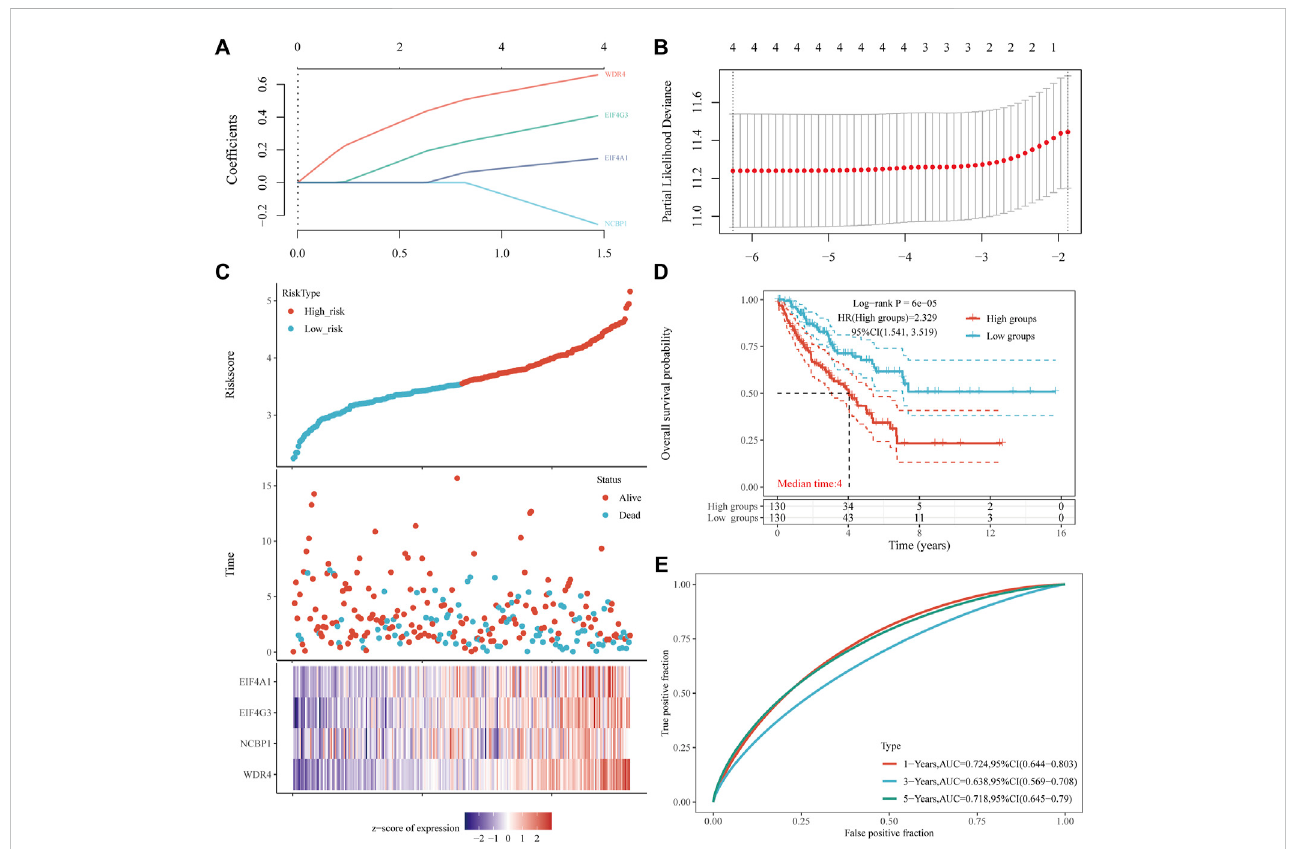
FIGURE 7 Construction of a prognostic m7GRG model. (A) LASSO coef fi cient pro fi les of prognostic m7GRGs, (B) Plots of the ten-fold cross-validation error rates. (C) Distributionoftheriskscore,survivalstatus,andtheexpressionofprognosticm7GRGsinsarcomas. (D,E) OScurvesofsarcomapatientsinthehigh-/low- risk group and the ROC curve for measuring the predictive